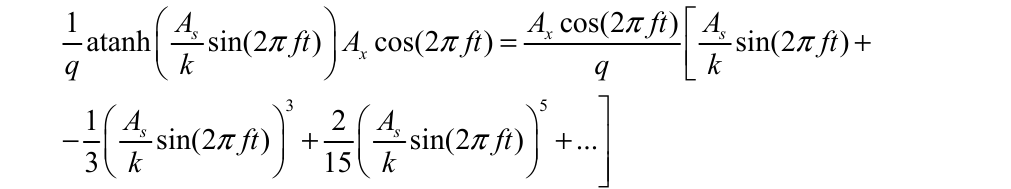
Figure 8. General diagram for measuring C from the output voltage by performing the operation LPF[V